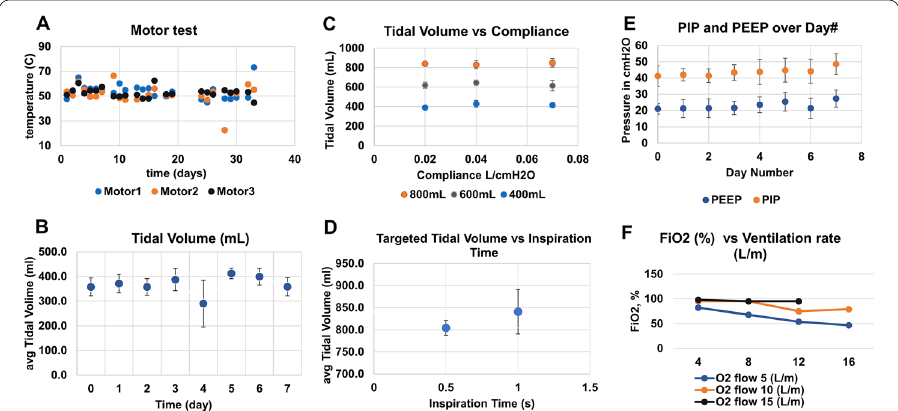
Fig. 2 Bench testing results with the lung simulator. A Cardone motors test at V T of 800 mL and RR of 50 bpm for 32 days. B Tidal volume consistency of the AMBU Spur II bag (n Tidal volume delivery measured at varying compliances (0.02, 0.04, 0.07 L/cm H 2 O) for 3 tidal volumes of 200, 400 and 800 mL, and 1 s for T I . D Tidal volume performance as a function of changing inspiratory time at a fixed compliance of 0.02 L/cm